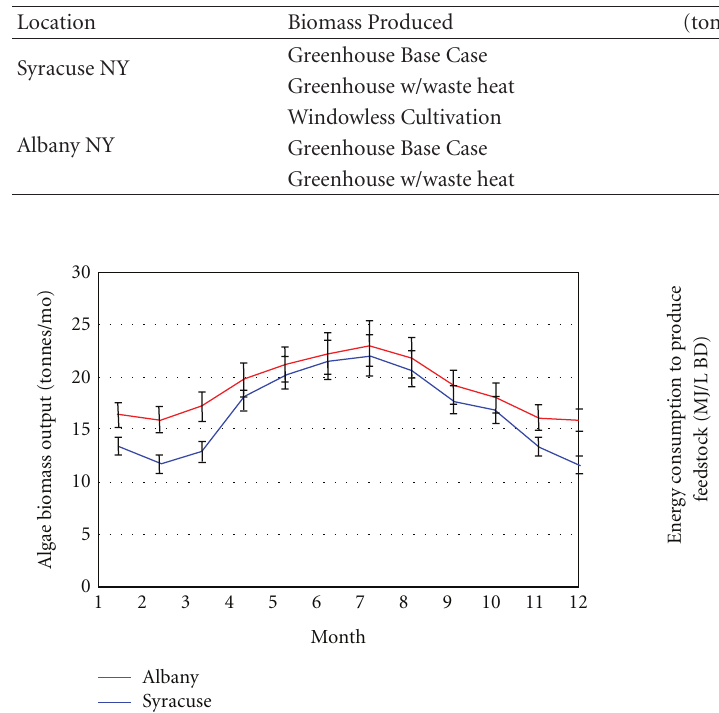
Figure 6: Energy consumption for microalgae and soy bean feedstock production. The error bars represent 95% confidence intervals on the total energy consumption for feedstock